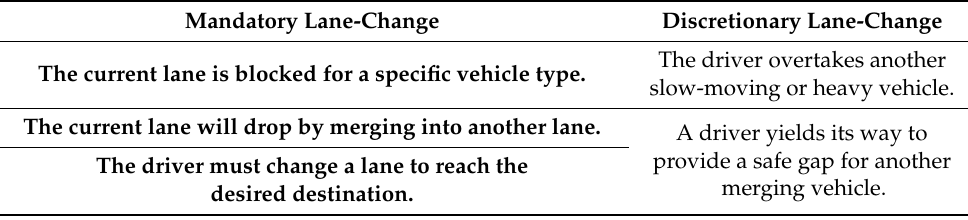
Table 3. Lane change classification in micro-simulation tools [47].